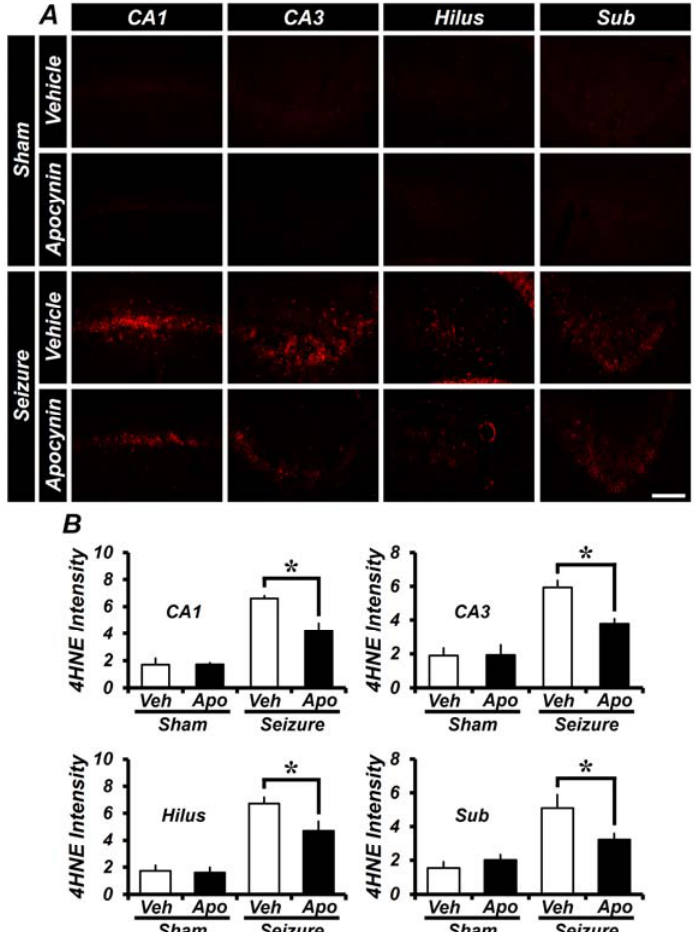
Figure 5. Apocynin treatment reduces 4HNE levels in the hippocampus at 4 weeks after seizures. ( A ) A microscopic image showing oxidative injury with 4HNE at each region of the hippocampus. The intensity of 4HNE was increased in the seizure group when compared to the sham-vehicle group. The 4HEN intensity was reduced in the seizure-apocynin treatment group when compared to the seizure-vehicle group. Scale bar = 100 µ m. ( B ) The bar graph shows the quantification of the levels of 4HNE in each region of the hippocampus. Data: Mean ± S.E.M., n = 5–8 from each group, * p < 0.05.